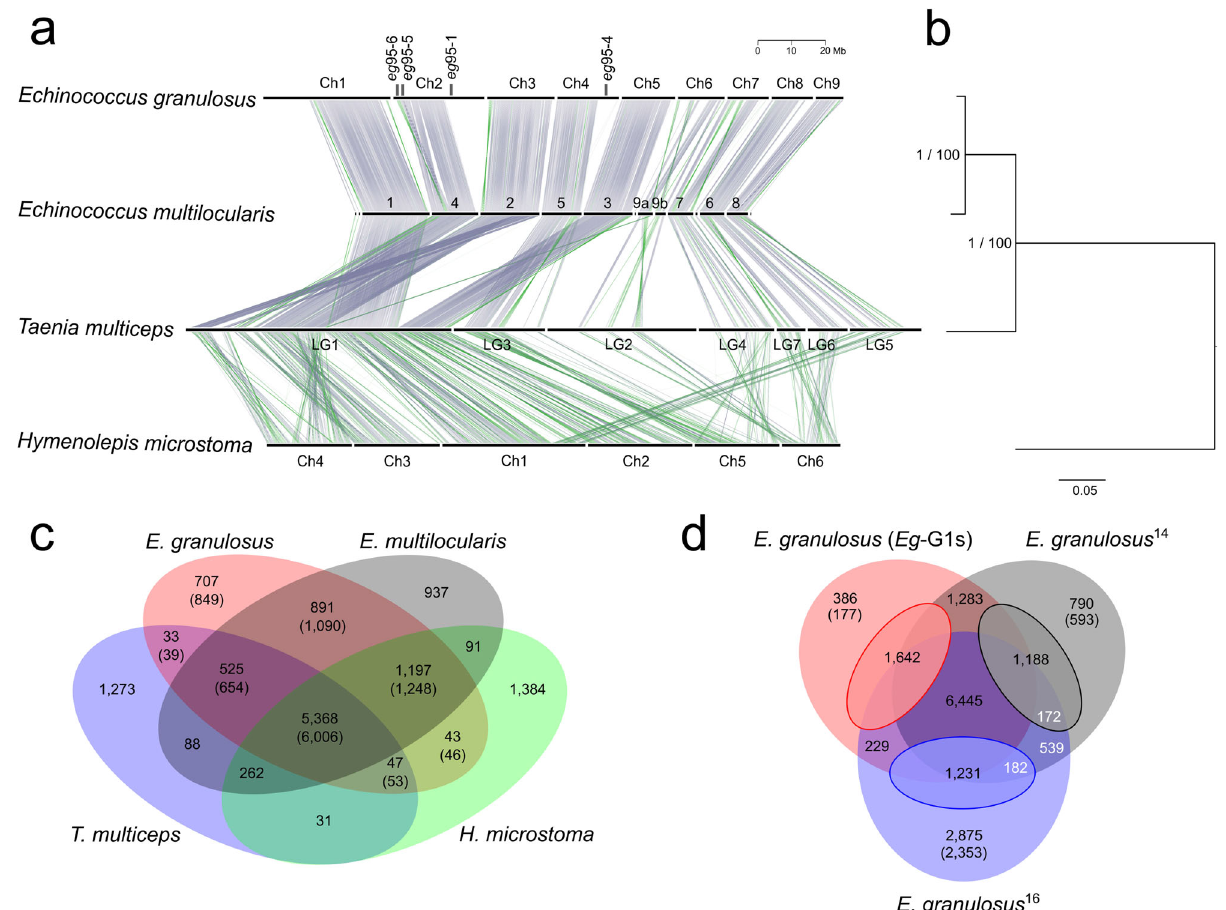
Fig. 2 Synteny, relationships and orthology. a Synteny of the nine chromosomes (Ch1 to Ch9) of the genome Eg- G1s of Echinococcus granulosus (genotype G1) with scaffolds or chromosomes in the genome assemblies of E. multilocularis 14 , Taenia multiceps 22 and Hymenolepis microstoma 23 . Each line represents a single copy orthologous (SCO) gene between two species (grey — same orientation; green — reverse orientation). Scale bar (top right) indicates chromosome length (Mb). b Consensus tree showing the genetic relationship of the four cestode species using data for 4040 shared SCOs (nodal support values: 1.0 and 100% for MrBayes and RAxML analyses, respectively; scale bar: substitutions per sequence site). c Venn diagram displaying the numbers of orthogroups between or among the four cestode species obtained using the program OrthoFinder 68 (numbers of E. granulosus genes in parentheses). d Venn diagram comparing the numbers of genes (using OrthoFinder) common or distinct between or among the reference genome Eg- G1s (top left) and previously published assemblies 14,16 . Numbers of paralogous genes (small ovals) and orthologous and/or single copy genes (large ovals and overlaps) are indicated, as are orphan (unknown) genes (in parenthesis). Numbers of gene predicted ( n = 1432; 539 + 172 and 539 + 182) from two previous draft genomes of E. granulosus 14,16 for which homologous protein-coding genes were not identi fi ed in the fi nal gene set of Eg- G1s. White lettering was used only to improve visibility of numbers on dark